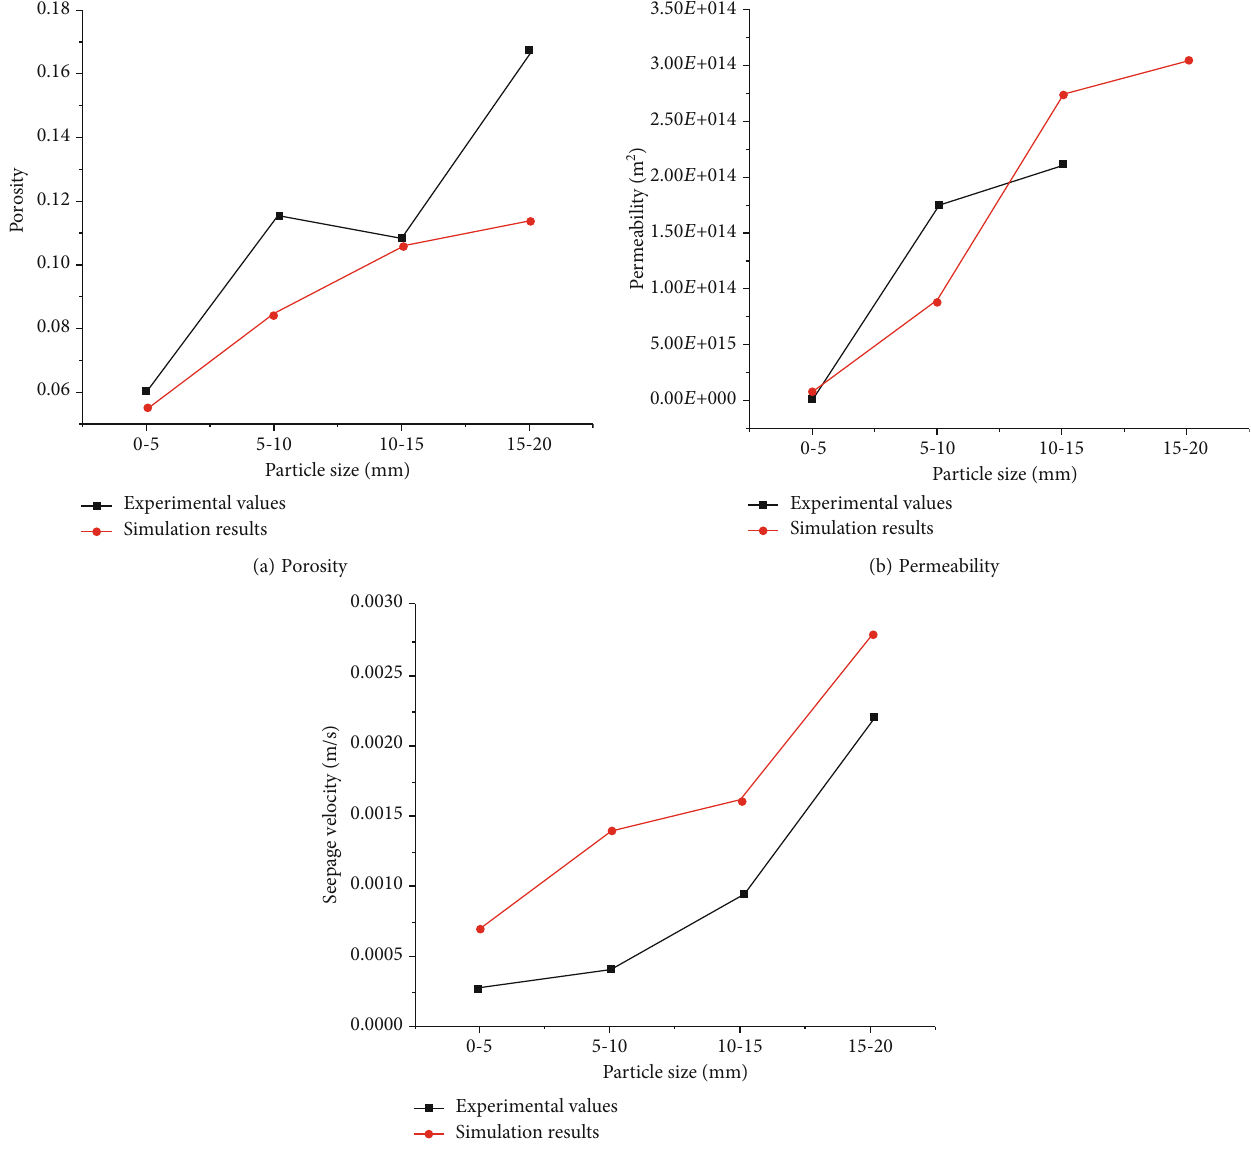
Figure 16: Comparison between the experimental and numerical simulation data for di ff erent sizes of